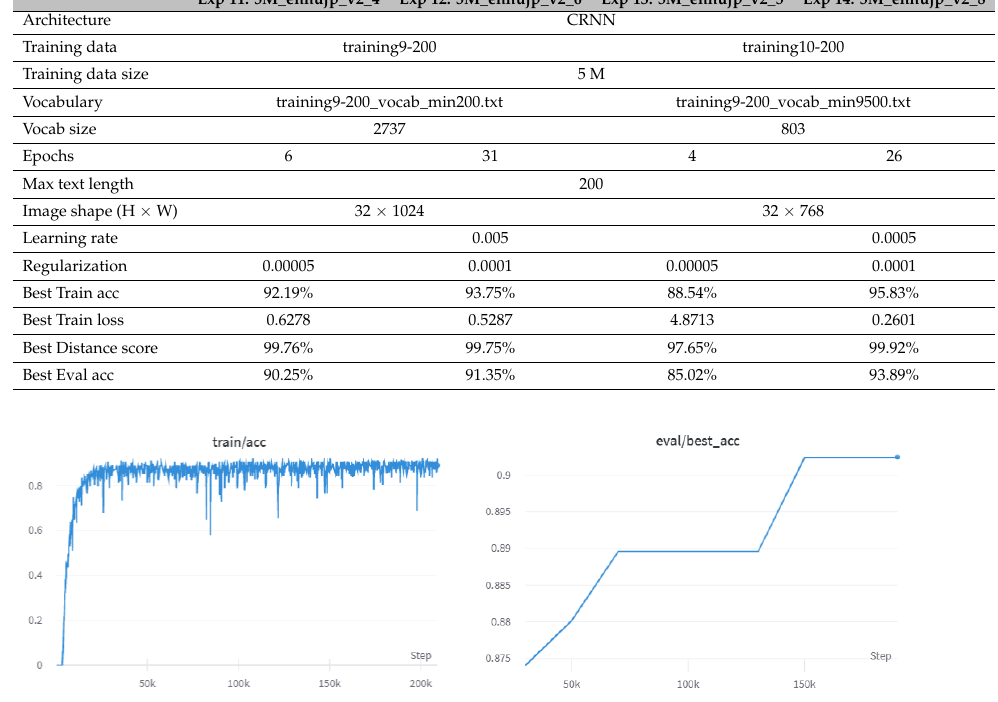
Table 13. Multilanguage Experiments: 11, 12, 13, and 14.